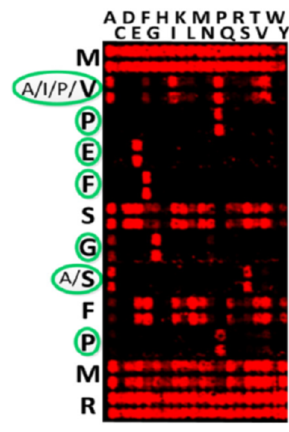
Figure 1. Substitutional analysis of peptide MVPEFSGSFPMR reveals the binding motif X–A/I/P/V–P–E–F–X–G–A/S–X–P–X–X [8]. The double spot array was used. Reproduced with permission, Copyright 2017, ELSEVIER.